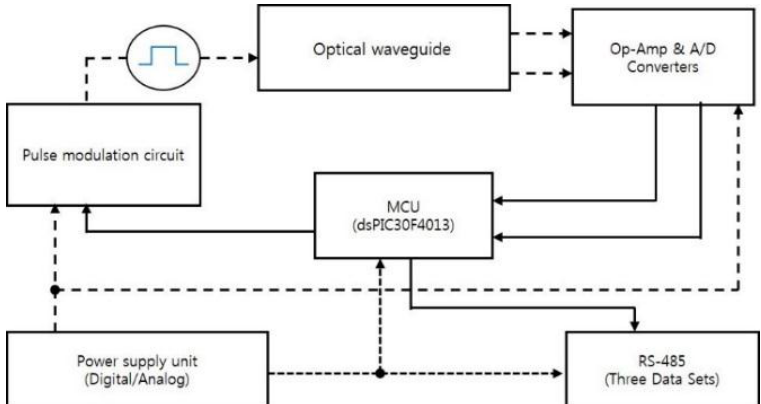
Figure 4. Block diagram of signal conditioning circuit.